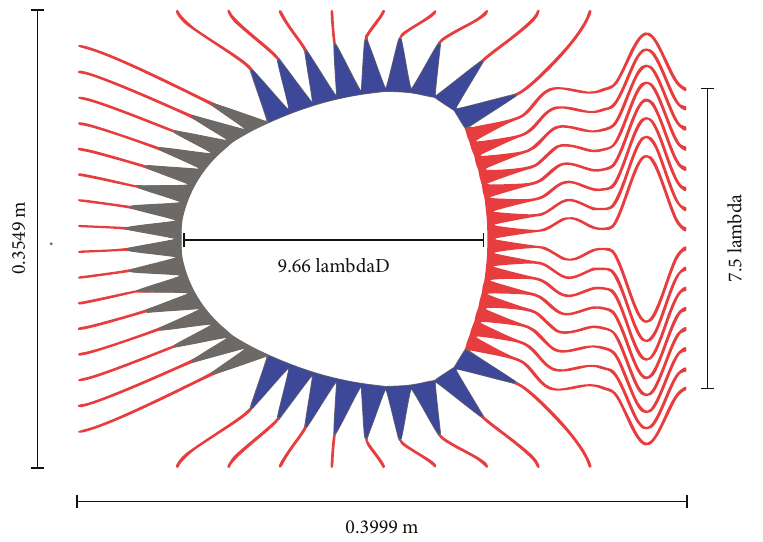
Figure 3: Lens obtained through the QLWS-based optimization.